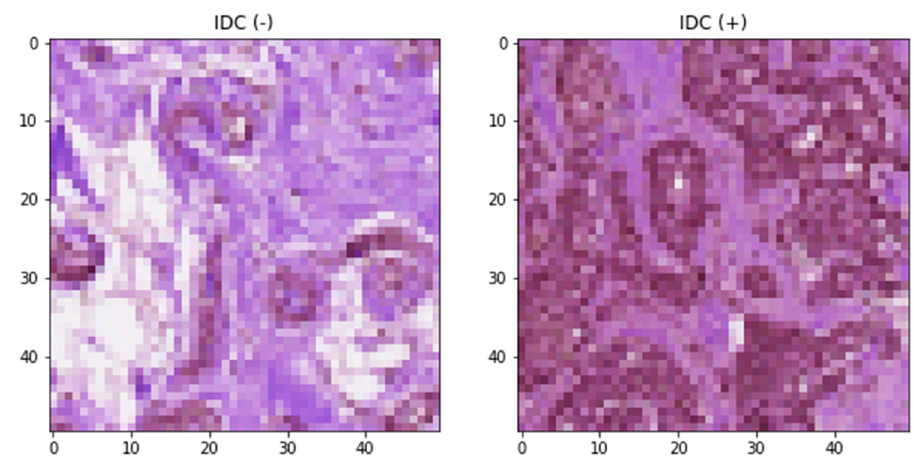
Figure 6. Preprocessed extracted patches from the data samples.